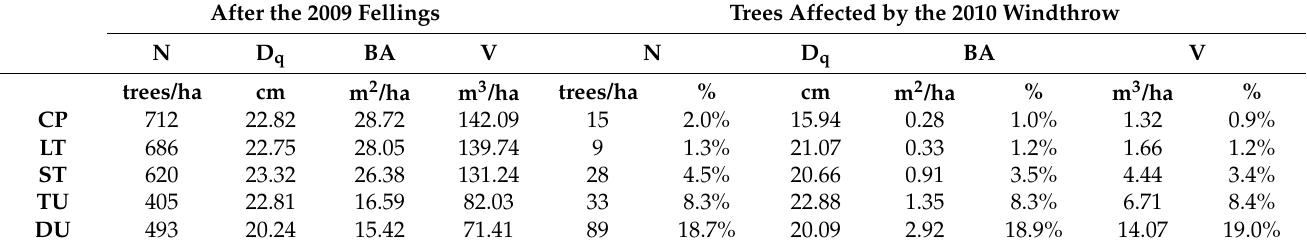
Table 3. Main parameters of the research plots for each treatment in 2009 before the extreme weather event and characteristics of the trees affected by the 2010 windthrow (total value and percentage compared to